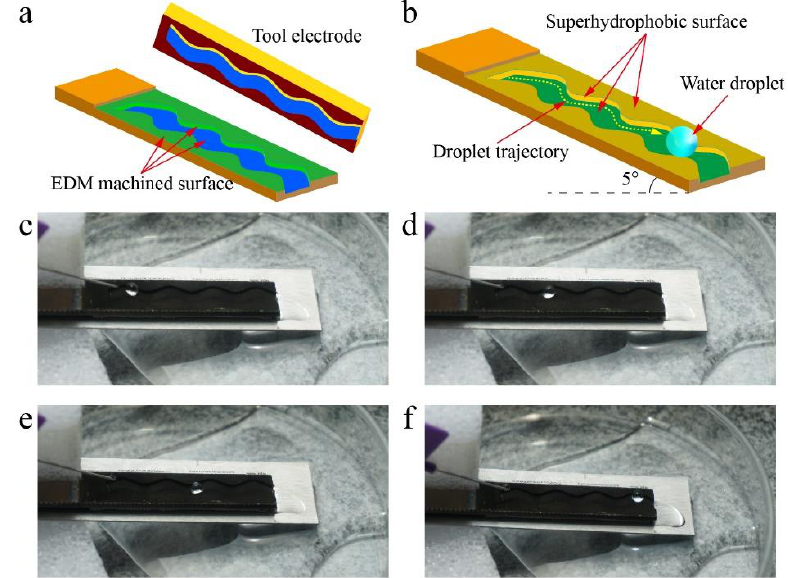
Figure 12. Water droplet transported on the superhydrophobic surface. ( a ) Complex trajectory machined by EDM. ( b ) Mechanism of the water droplet transported on the as-prepared superhydrophobic surface. ( c – f ) Photograph of the water droplet moving along the trajectory on the as-prepared superhydrophobic